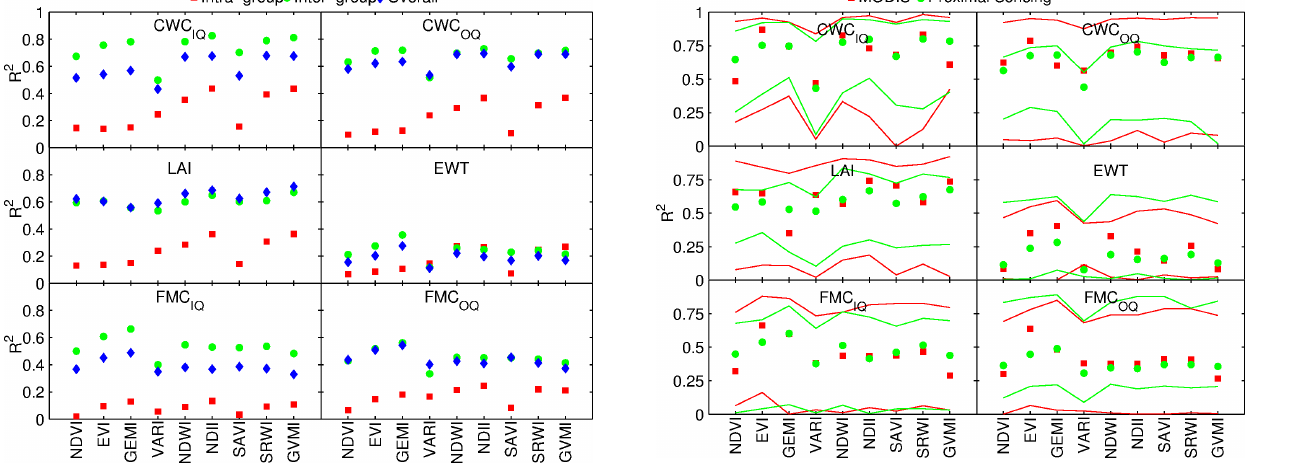
Figure 4. Intra-group, inter-group and overall R 2 values between proximal sensing spectral indexes and biophysical variables mea- sured in the field.